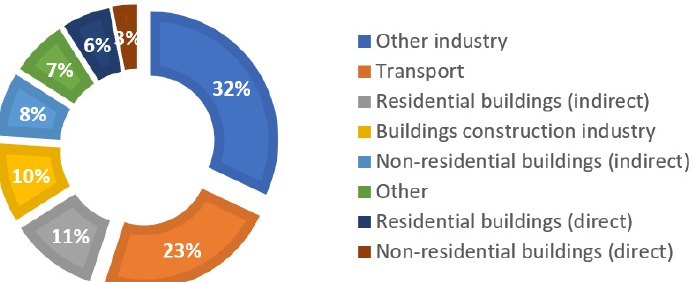
Figure 1. Global share of buildings and construction final energy, 2019. Adapted from [10].